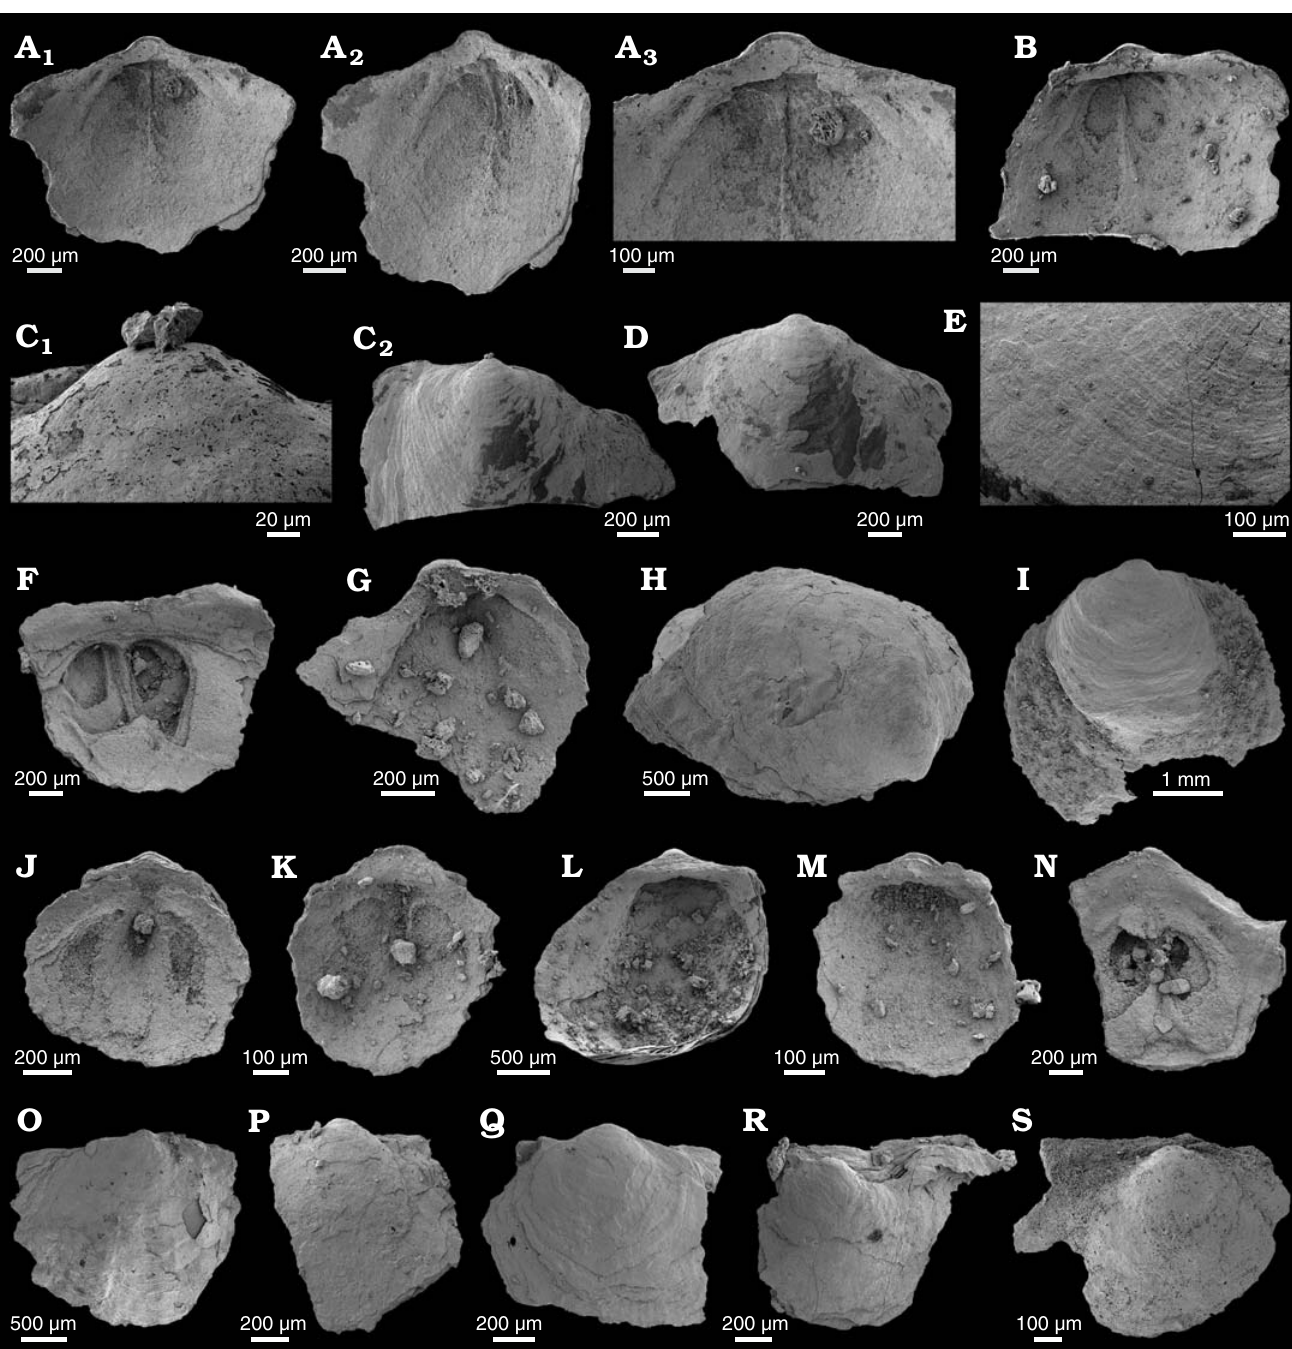
Fig. 11. The lingulid brachiopod Cordatia erinae Brock and Claybourn gen. et sp. nov. from the lower Cambrian of South Australia, Ajax Limestone, Flinders Ranges (AJX-M/415) (A–E) and White Point Conglomerate, Kangaroo Island (F–S). Ventral (A, D, G) and dorsal (B, C, E, F, H–S)